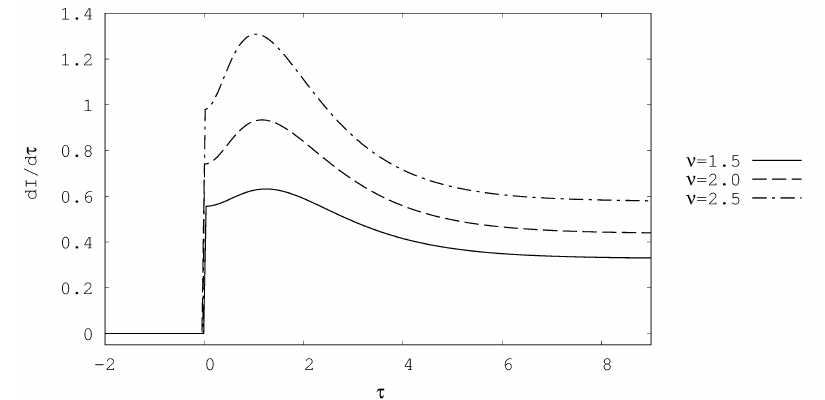
Figure 4 . Time dependence of the WDW action in the non-rotating case for di(cid:11)erent values of (cid:23) . We set G = 1, l = 1, r 0 = 1 and A = 2. The critical time t C corresponds to (cid:28) =